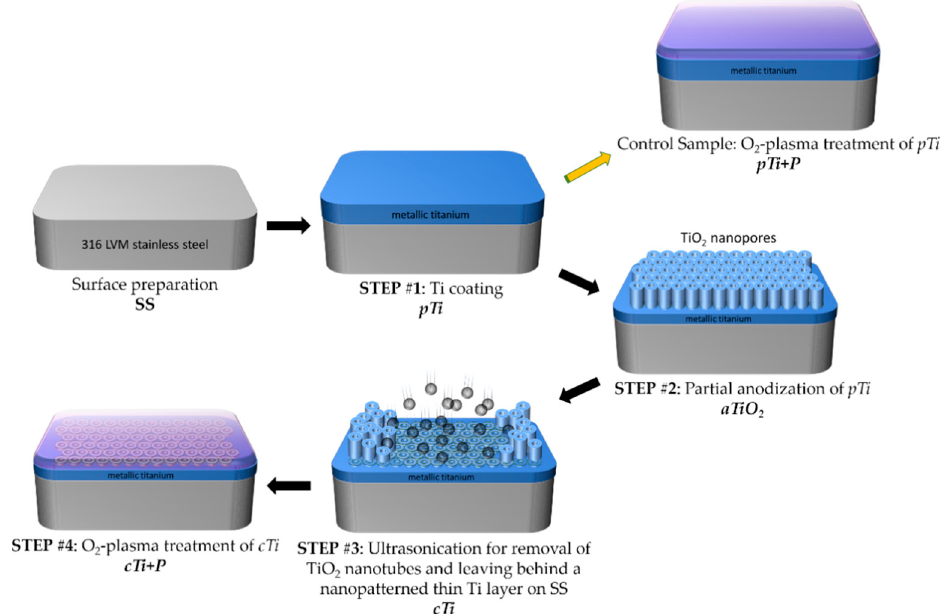
Figure 1. Surface preparation steps: #1 titanium coating on stainless-steel, #2 anodization of titanium, #3 ultrasonication of nanoporous TiO 2 , and #4 O 2 -plasma treatment of cTi